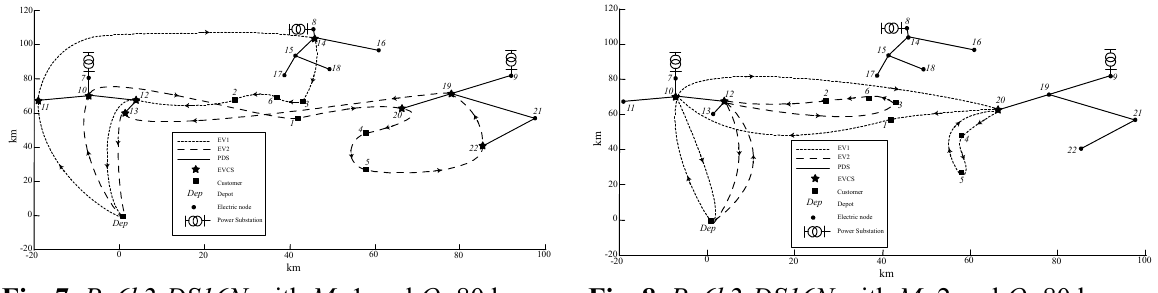
Fig. 7. Pn6k2-DS16N with M =1 and Q =80 km Fig. 8. Pn6k2-DS16N with M =2 and Q =80